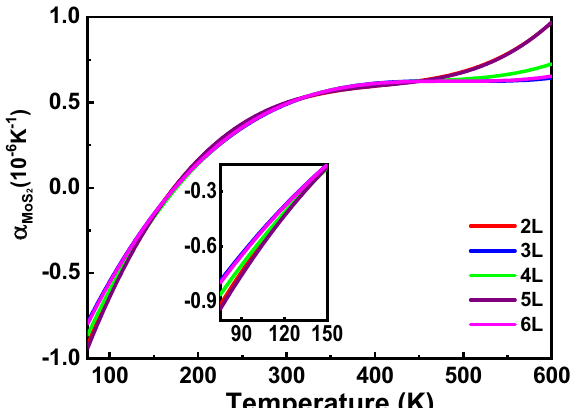
Figure 5. Calculated TECs of MoS 2 with different numbers of layers. The inset figure shows a magnified view of the TECs in the temperature range of 75–150